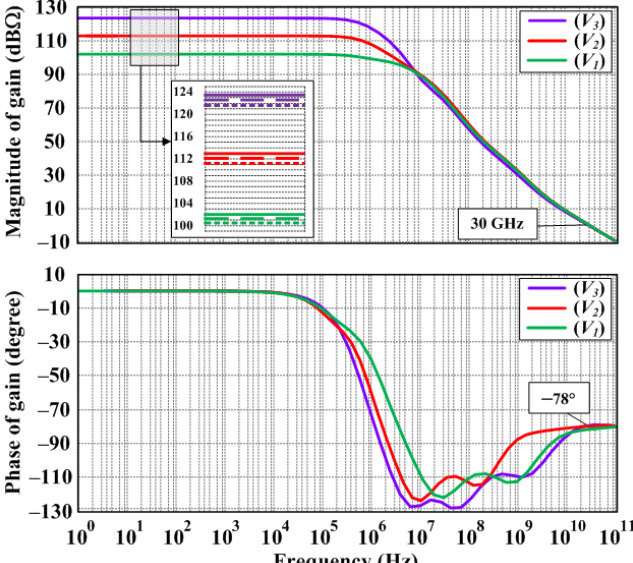
Figure 4. Upper panel: magnitude of the circuit transimpedance gain as function of the frequency for different gain settings by acting on the external control voltages V 1 , V 2 , and V 3 . In the inset, the corresponding fine tuning achieved by varying the control voltage V AN . Lower panel: the corresponding values of the phase of the circuit transimpedance gain.